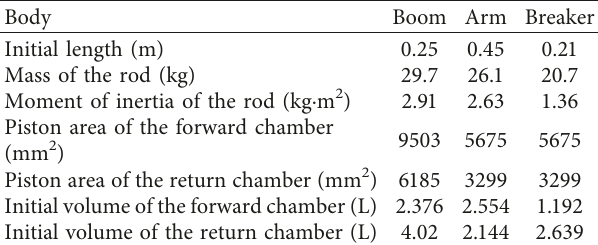
Table 3: Parameters of the hydraulic cylinders.